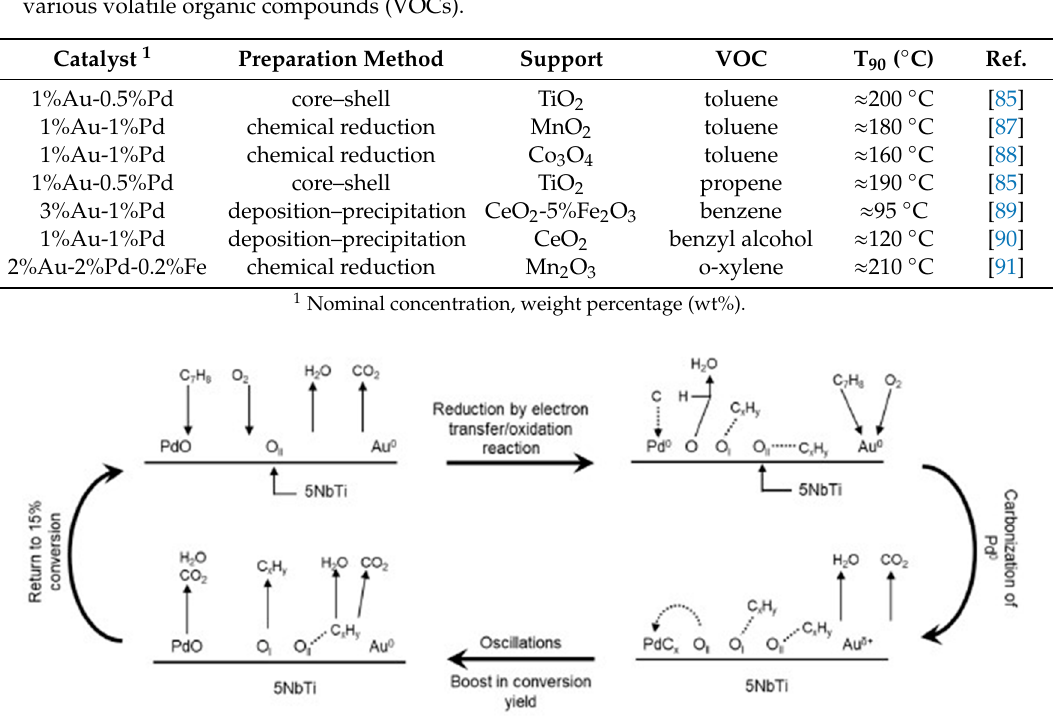
Figure 3. Catalytic oxidation of toluene under ageing condition over Au-Pd / Nb-TiO 2 catalyst. Figure from [86].